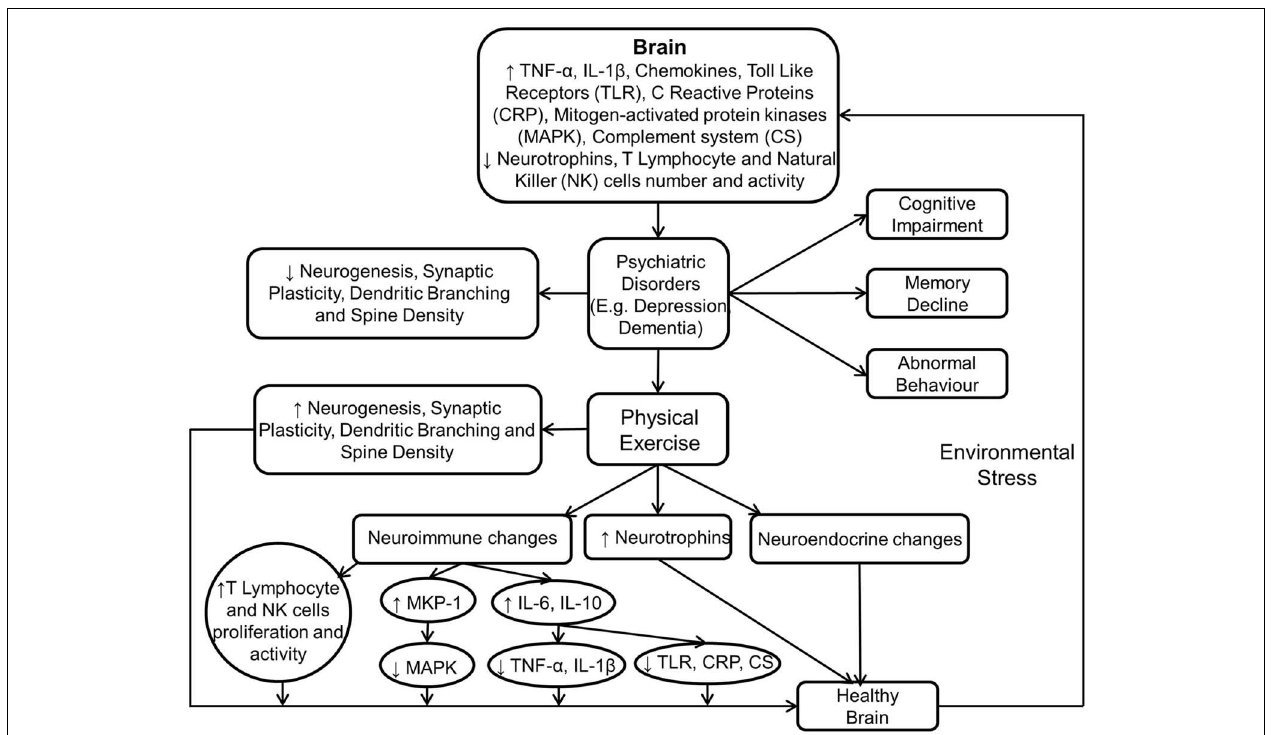
FIGURE 3 | Physical exercise modulates neuroimmune and neuroendocrine mechanisms to induce beneficial effects in the brain. This figure shows that psychiatric disorders are the result of aversive